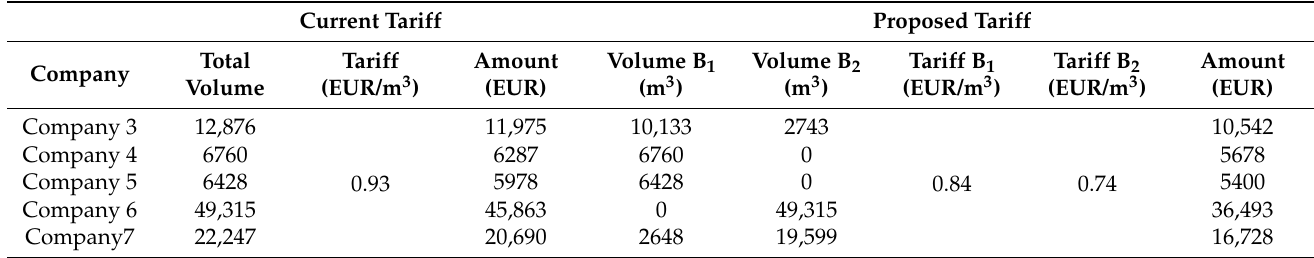
Table 10. Results for sector 2: current situation and proposal for consumptions (quarterly).